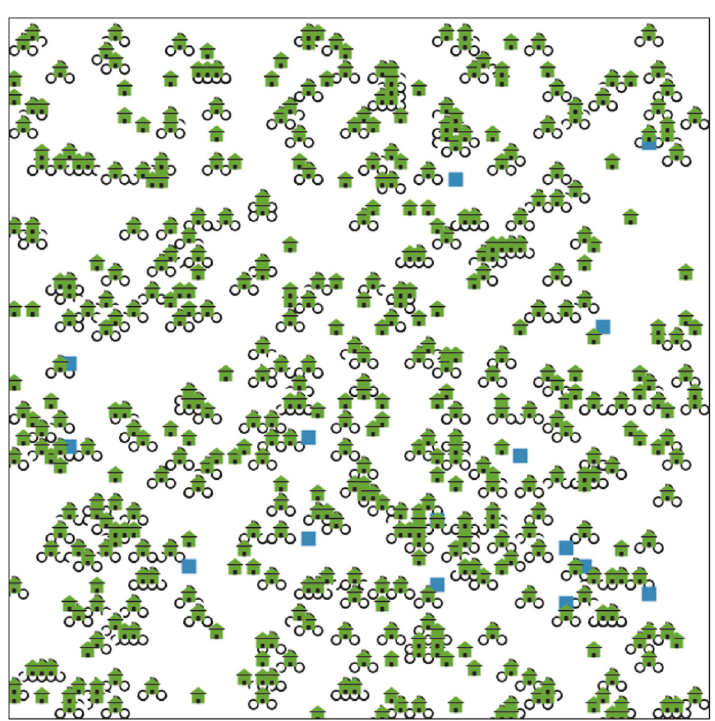
Figure 3: A view of the simulation world, when initialized for 500 sources, 550 vehicles, and 15 resources (blue